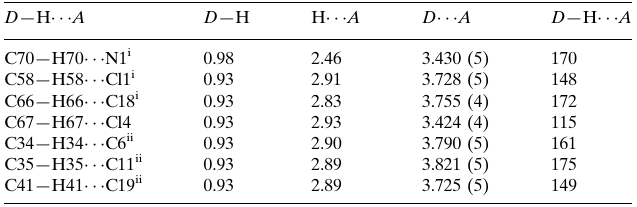
Hydrogen-bond geometry (A˚ , (cid:2)